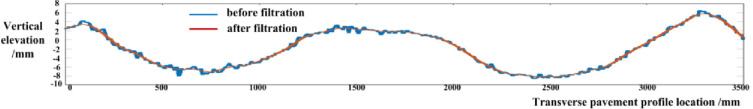
Rut profile before and after filtration.